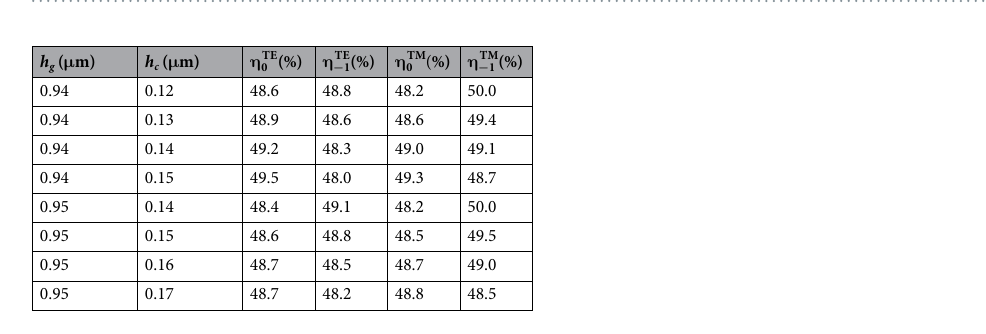
Table 1. The actual parameters fabrication tolerances with the period of 780 nm and duty cycle of 0.65 under Littrow